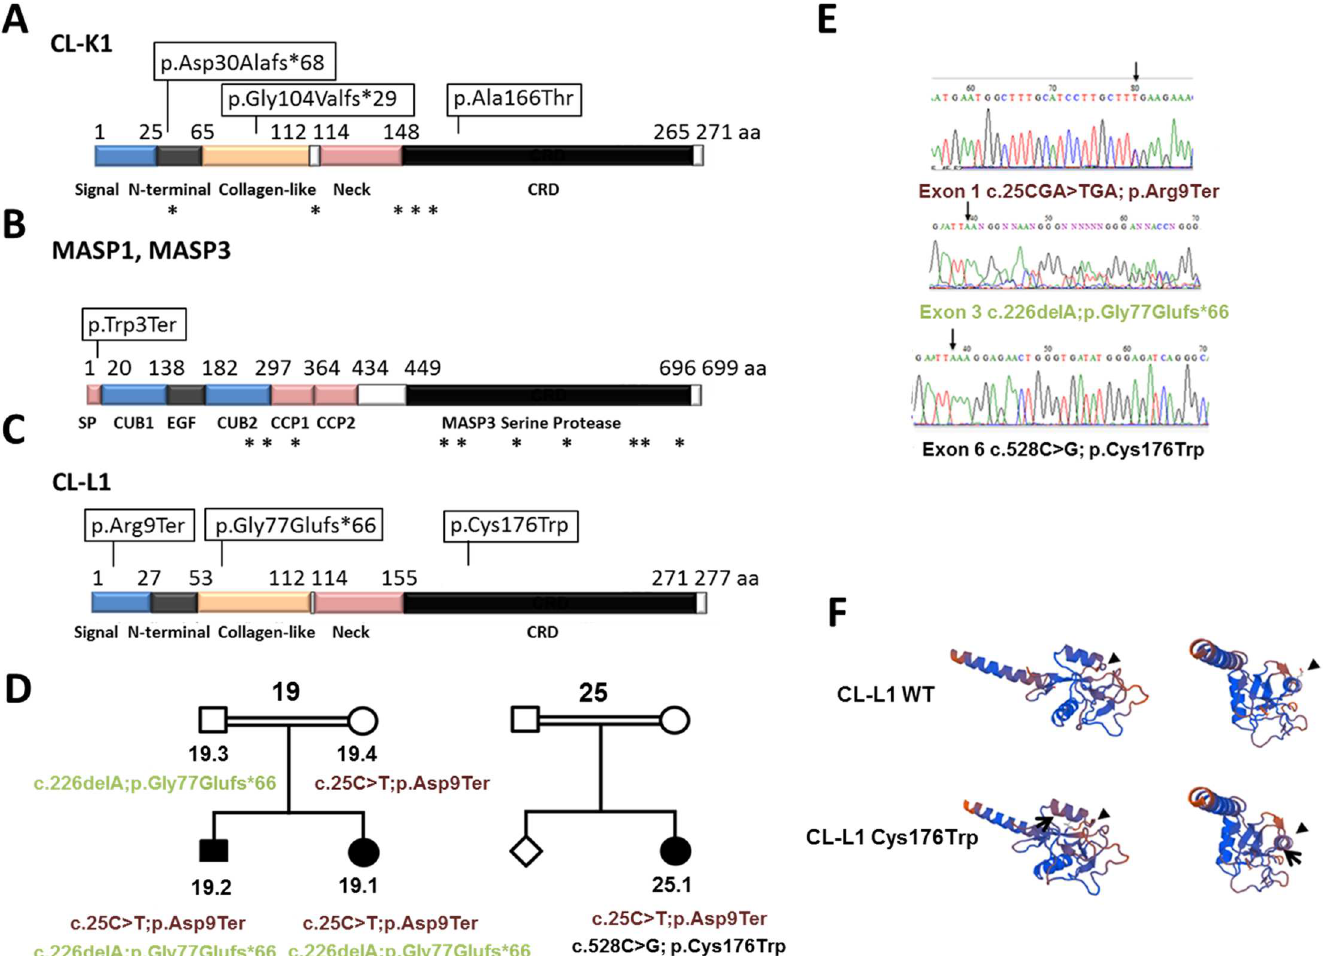
Fig 1. New 3MC mutations in COLEC11 , MASP1/3 and COLEC10 A-C. Summary of 3MC mutations positionin CL-K1, MASP1, MASP3 and CL-L1 proteins. Boxes indicate positionof new mutations describedin this work. Asterisks indicatealready known mutations. D. Pedigreesof families 19 and 25 with COLEC10 mutations. COLEC10 mutations are indicatedunder carriers and affected patients. E. Chromatogram of new COLEC10 mutations. F. Tridimensional structure by SWISS-MODEL Workspace for Wild-type and Cys176Trp mutated CL-L1. On the left, lateral view of the second helix-loop- helix domain. This domainis part of the C-lectin type domain. On the right, forward view. Arrow indicatesthe positionof the missensechange p. Cys176Trp. The structure of CL-L1 c-lectin domain changesin p.Cys176Trp mutants (arrowheads).